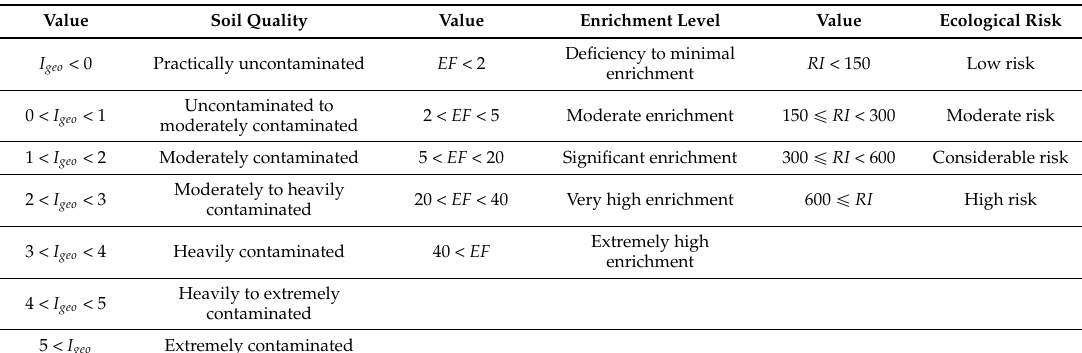
Table 2. Classification and description of geoaccumulation index ( I geo ), enrichment factor ( EF ) and potential ecological risk index ( PERI